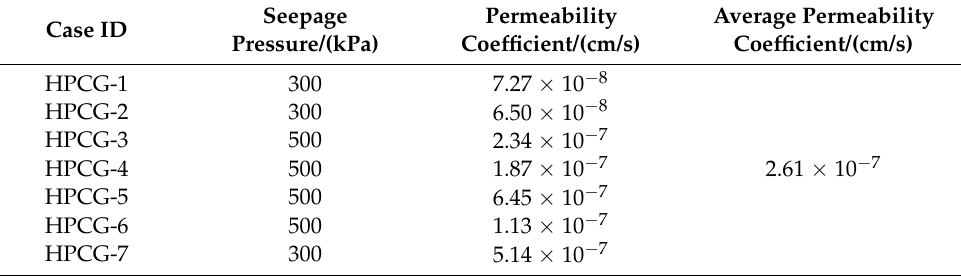
Table 6. Permeability coefficients of